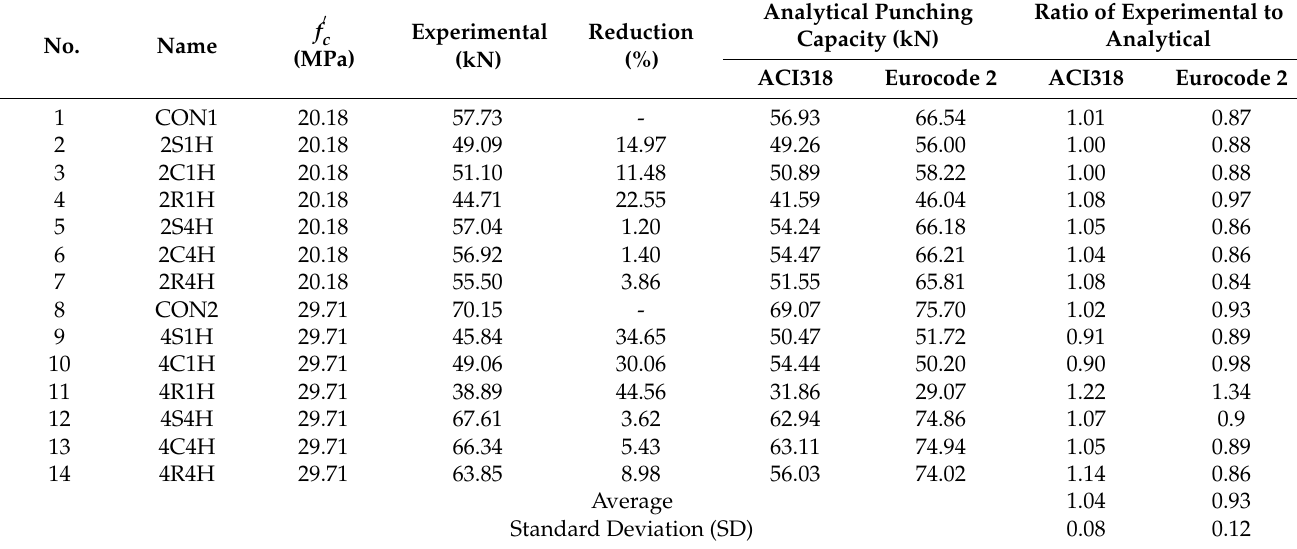
Table 4. Comparison between experimental and analytical punching shear